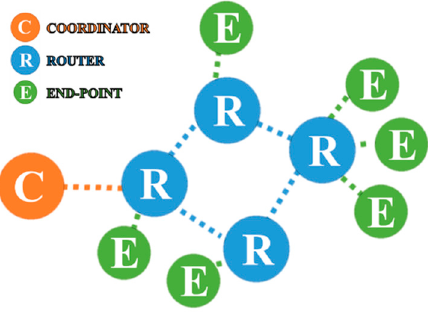
Figure 1. ZigBee Figure 1. ZigBee mesh.